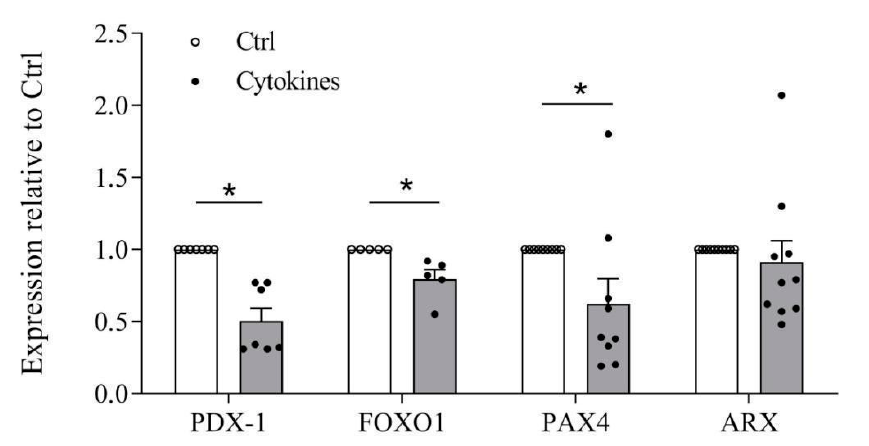
Figure 4. PDX-1 , FOXO1 , PAX4 , and ARX gene expression (relative to control) assessed by RT-PCR after 48 h exposure to cytokines. * p < 0.05.